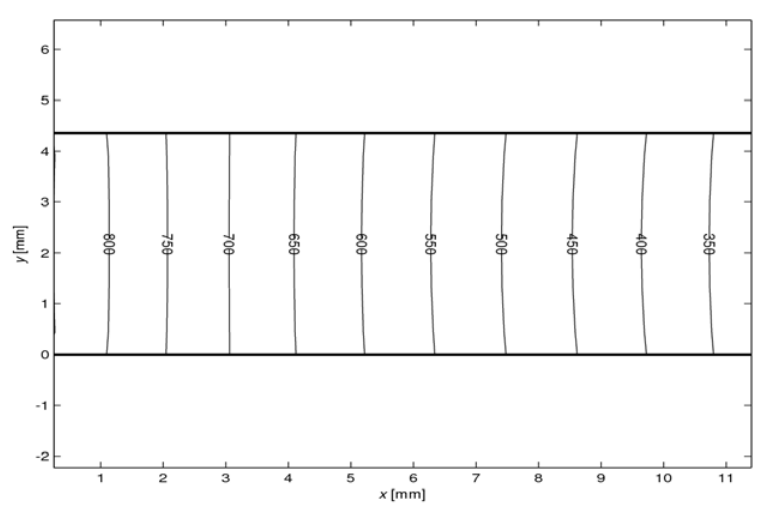
Figure 12. 2D temperature profile in p-type leg for l = 10 mm